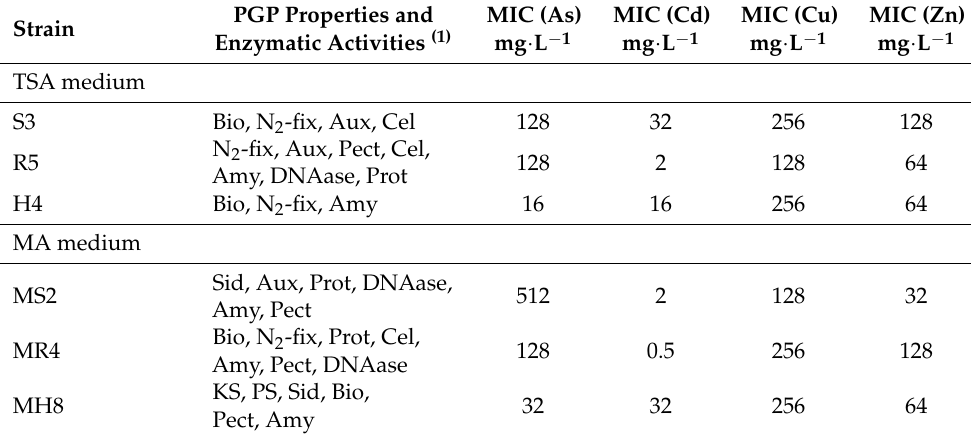
Table 1. Minimal inhibitory concentration (MIC) of metals/metalloids for the selected strains with the best plant-growth-promoting abilities and enzymatic activities. Strain selection was based on their PGP properties, their metal/loid resistance, and the “core genome” concept, by which most of the required PGP and metal resistance traits were present within the SynCom constituent’s